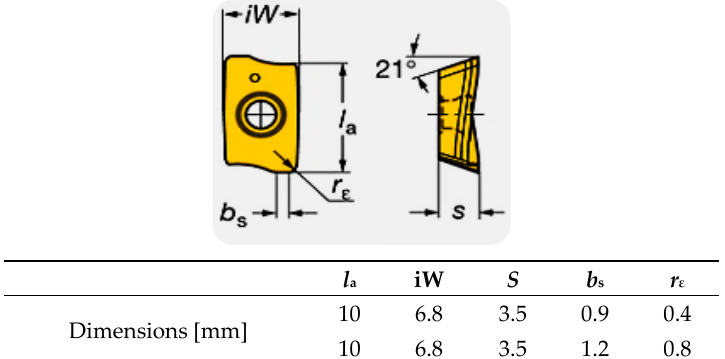
Figure 3. The geometric dimensions of the cutting tools used in milling operation.